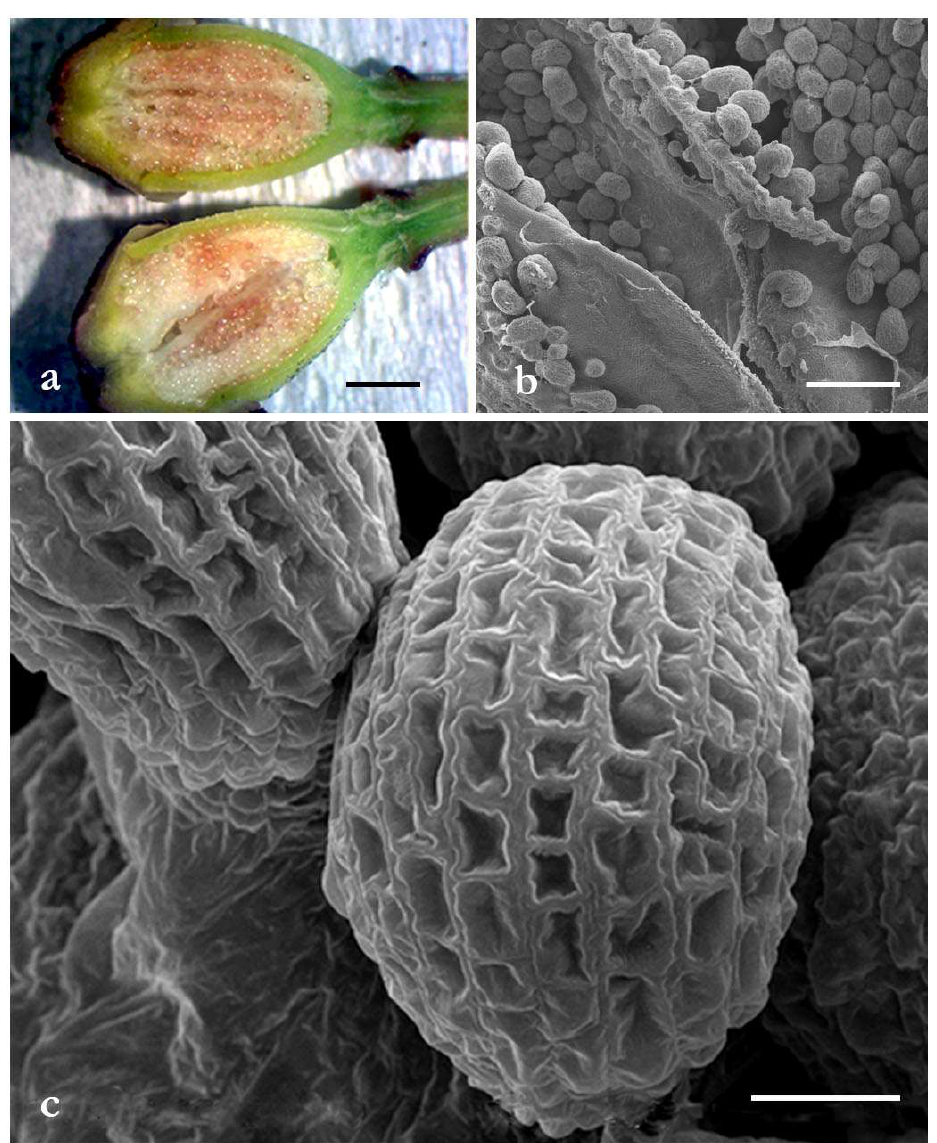
Figure 1. Ovules present inside the ovary observed by optical microscopy ( a ) and scanning electron microscopy ( b ). Ovules showed an elongated, round shape with a diameter of about 170 µm. Regular geometrical sculptures were present on the ovule surface ( c ). Bars: a, 2 mm; b, 500 µm; c, 50 µm.